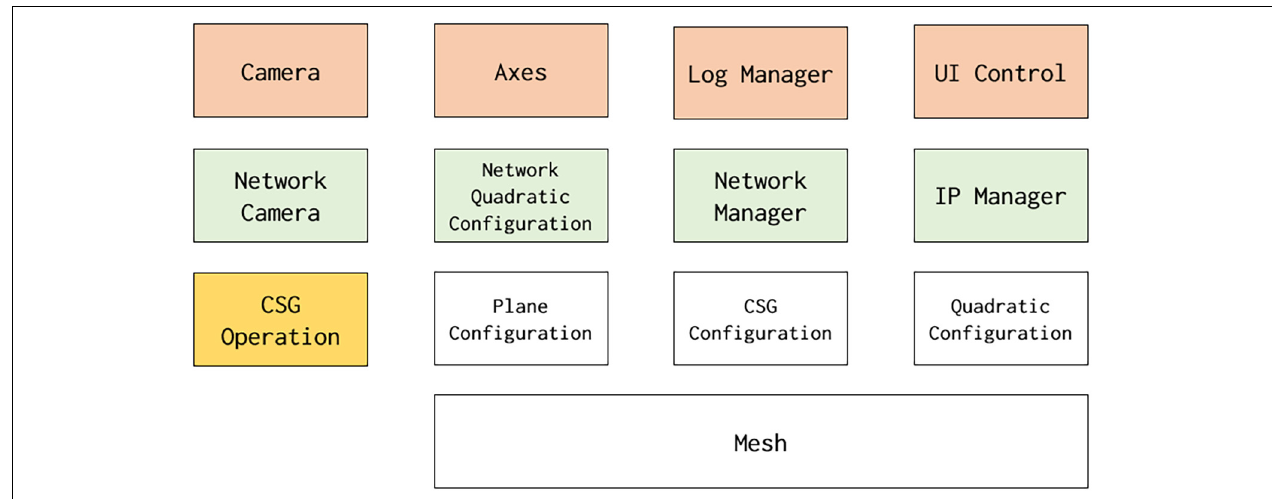
FIGURE 2 | Main components of the Lumen software.